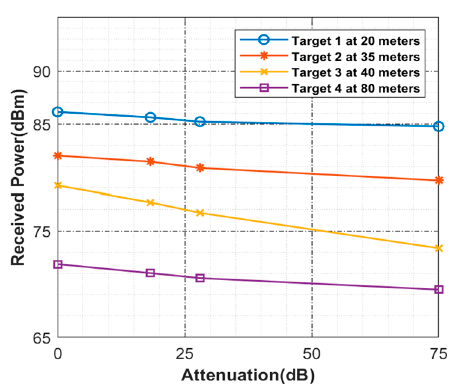
Figure 4. Computed SNR for targets with respect to atmospheric attenuation.